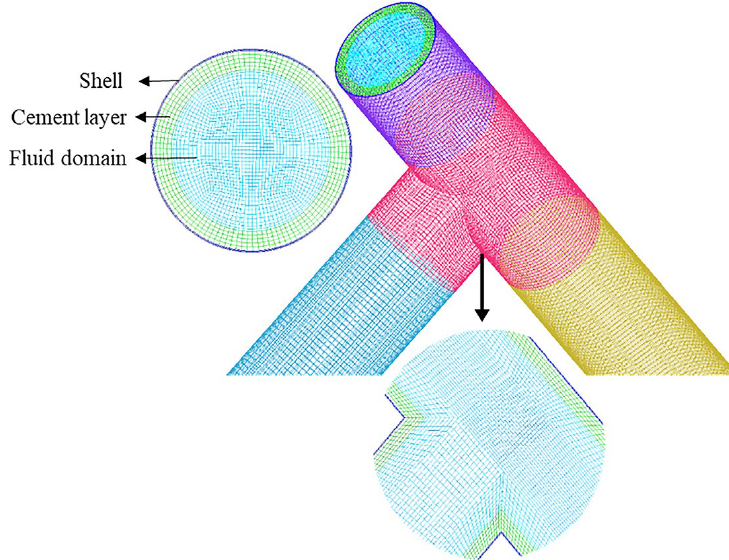
Figure 7. Computational grid.